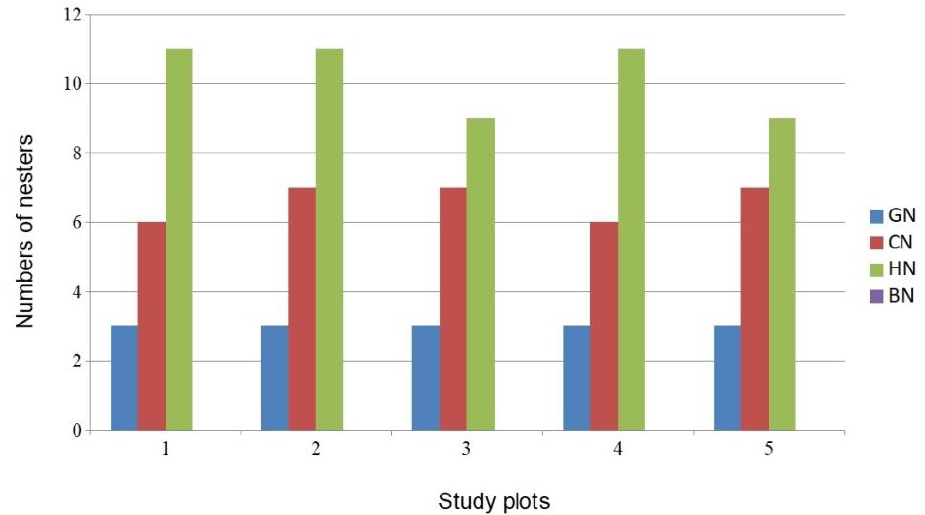
Figure 4. Structure of bird nesting guilds in study plots. (GN—ground nesters, CN—canopy nesters, HN—hole nesters, BN—bush nesters). Table 3. Comparison of bird and deer density between LPPLA and other localities in hardwood floodplain forests in the Czech Republic.